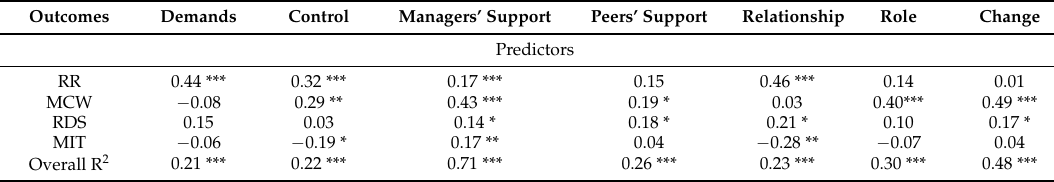
Table 4. Multiple regression analyses predicting Management